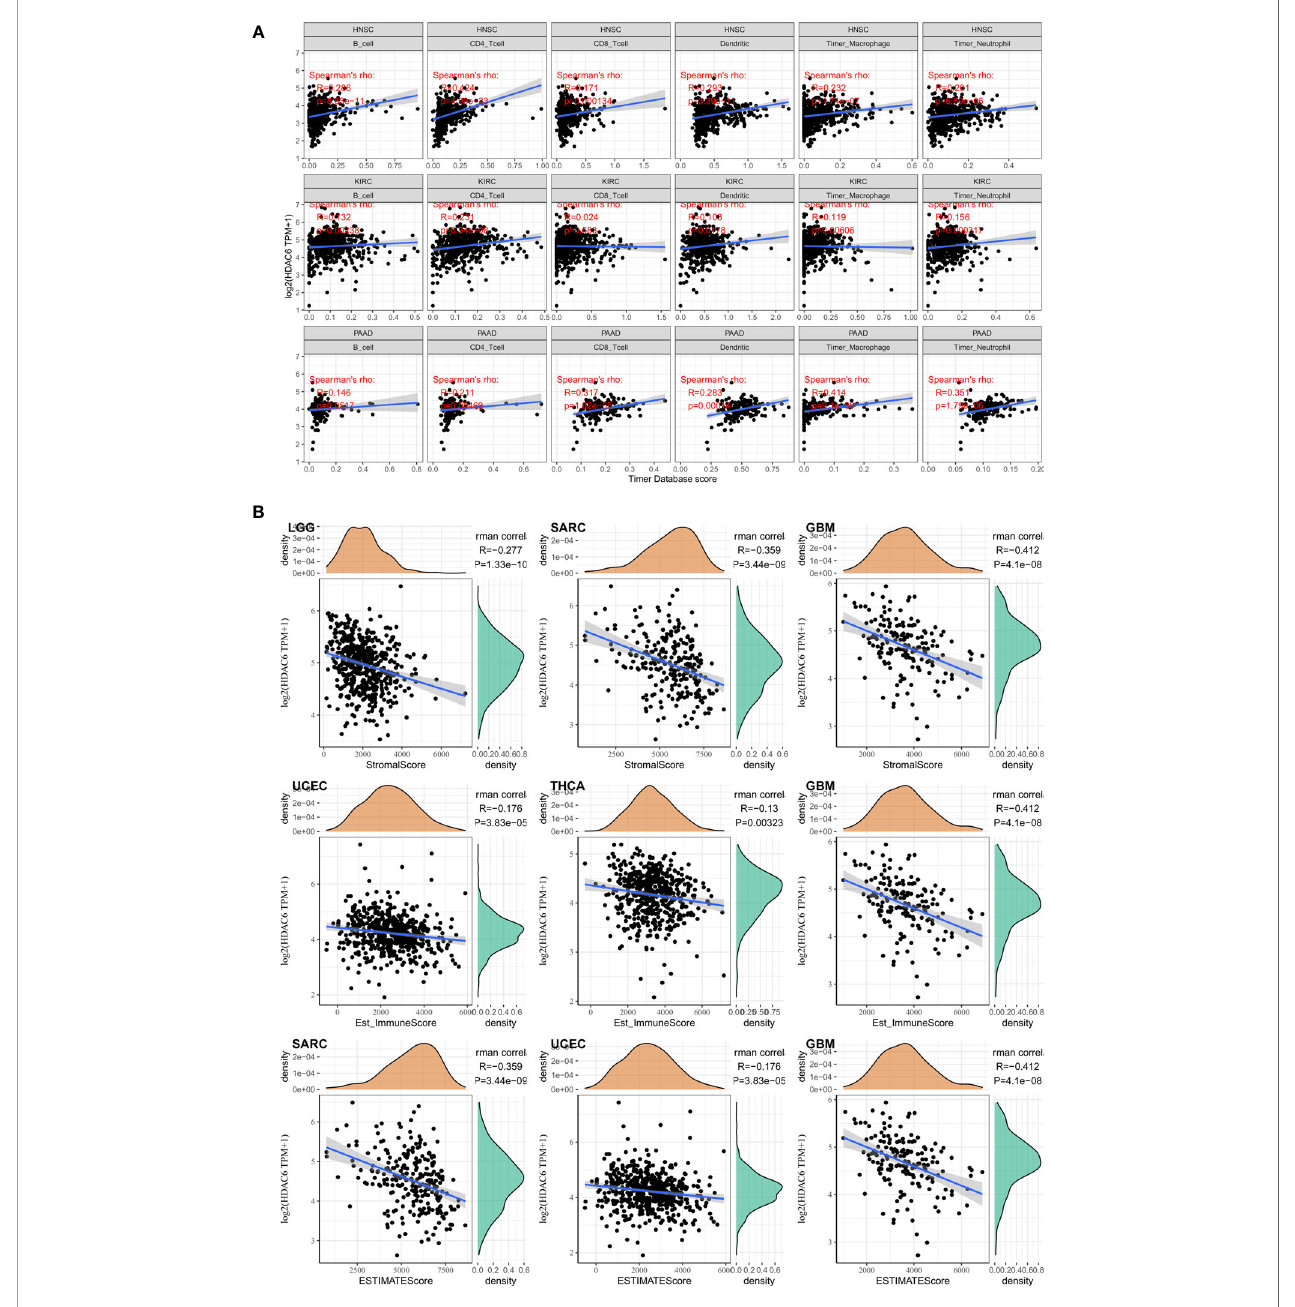
FIGURE 8 | correlation between HDAC6 and tumor immune in fi ltration and tumor microenvironment. (A) Correlation analysis between HDAC6 and immune cell in fi ltration in HNSC, KIRC, PAAD. (B) Relationship between HDAC6 expression levels and immune scores, stromal scores, and immune scores of